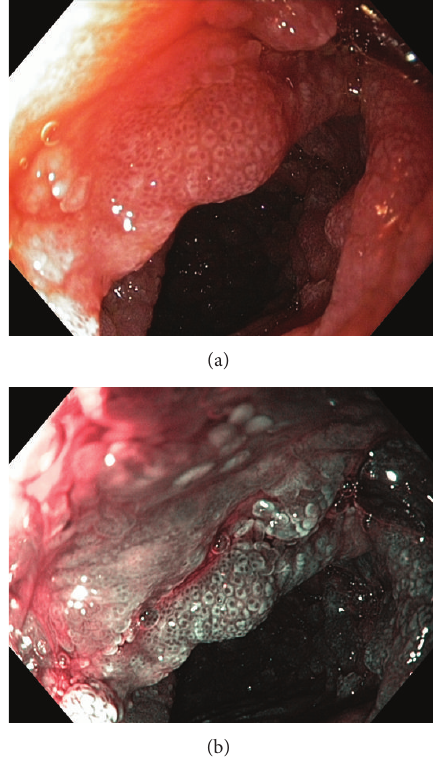
Figure 7: Duodenum. Atrophic changes with multiple strawberry- like polyps, high resolution white light endoscopy, and narrow band imaging